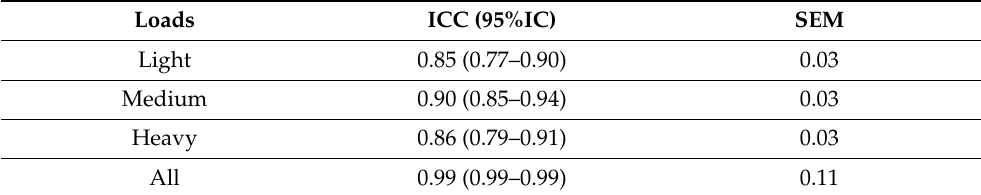
Table 5. Intraclass Correlation Coefficient (ICC: model 2, form 1) and Standard Error of Measurement